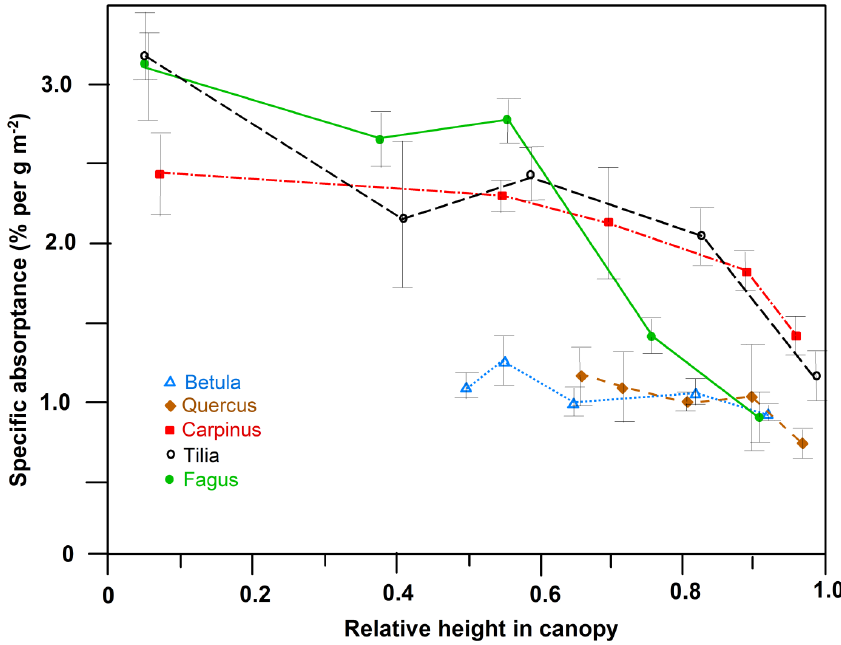
Figure 3. Transmittance ( a ) and absorptance ( b ) of PAR by leaves of the five species in dependence on height in the canopy (means of the 350–720 nm wave band, with consideration of leaf specular properties). Based on spectroradiometer measurements of each of 10 leaves per height level and species.